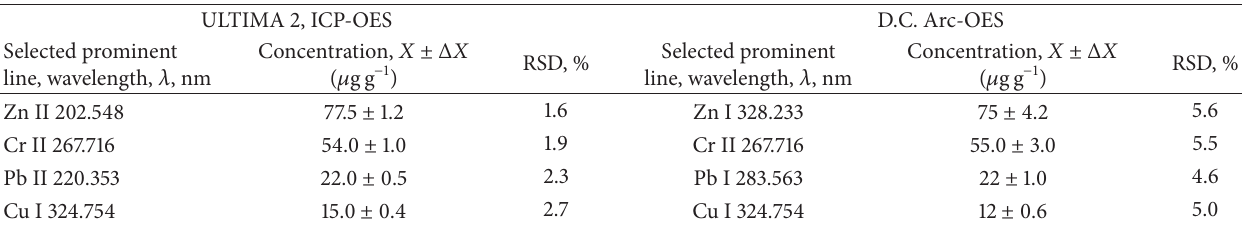
Table6:DeterminationofZn,Cr,Pb,andCuinsoilsample,obtainedbyULTIMA2:meanvalues[ 𝑋 ]for( 𝑛 = 4 replicates)andtheconfidence interval of the mean value [ Δ𝑋 ] for statistical confidence 𝑃 = 95 % and 𝑓 = 𝑛−1 = 3 (column 2); relative standard deviation (RSD %) (column 3). Columns 5 and 6 list the corresponding mean values [ Δ𝑋 ] for statistical confidence 𝑃 = 95 % and 𝑓 = 𝑛 − 1 = 3 (column 5) and RSD, %, obtained by D.C. Arc-OES.